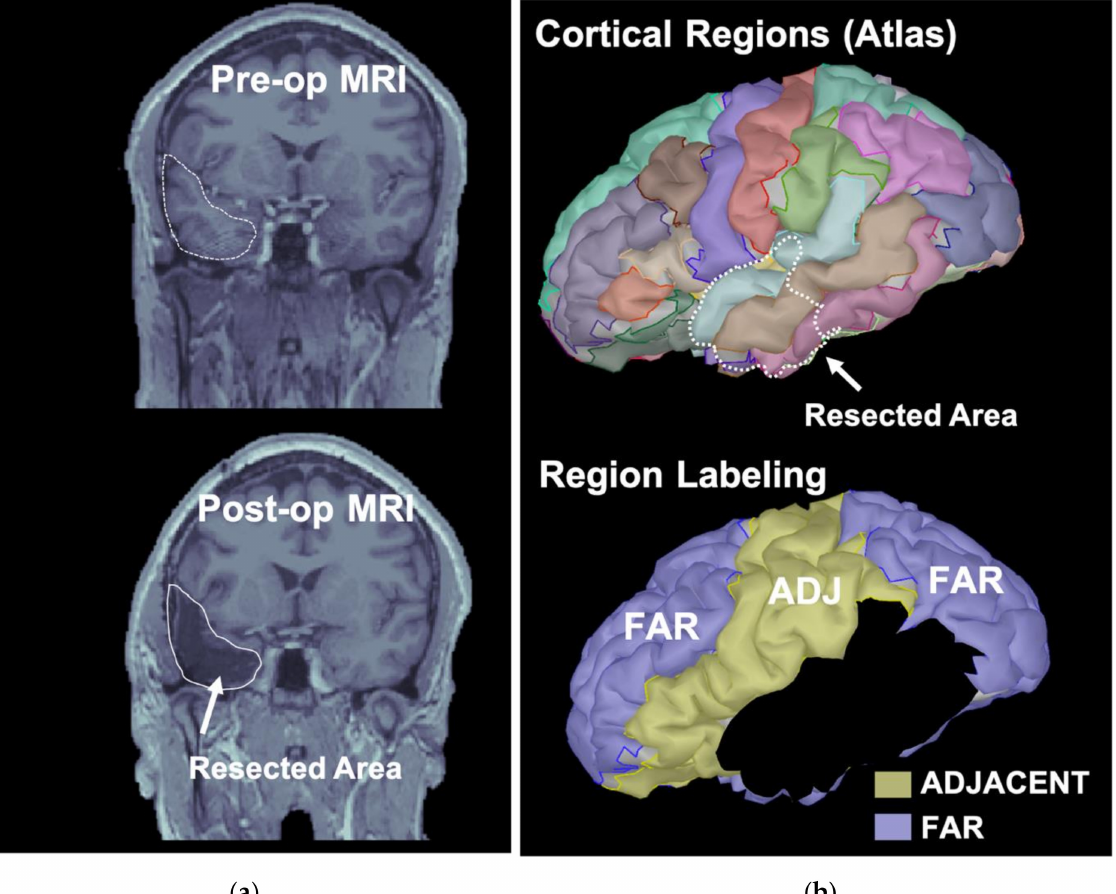
Figure 3. Resection and cortical region labeling. ( a ) Pre-operative ( top ) and post- operative ( bottom ) MRIs are displayed with the resected area (white outline). ( b ) Resected area (left temporal lobe in this patient) is displayed on top of the 68 cortical ROIs. The ROIs overlapping (even partially) with the resected areas were identified (black regions, bottom). All other ROIs were labelled as either adjacent to the resection (ADJ, in yellow) if within 10 mm from the closest margin of the resected area or far from the resection otherwise (in